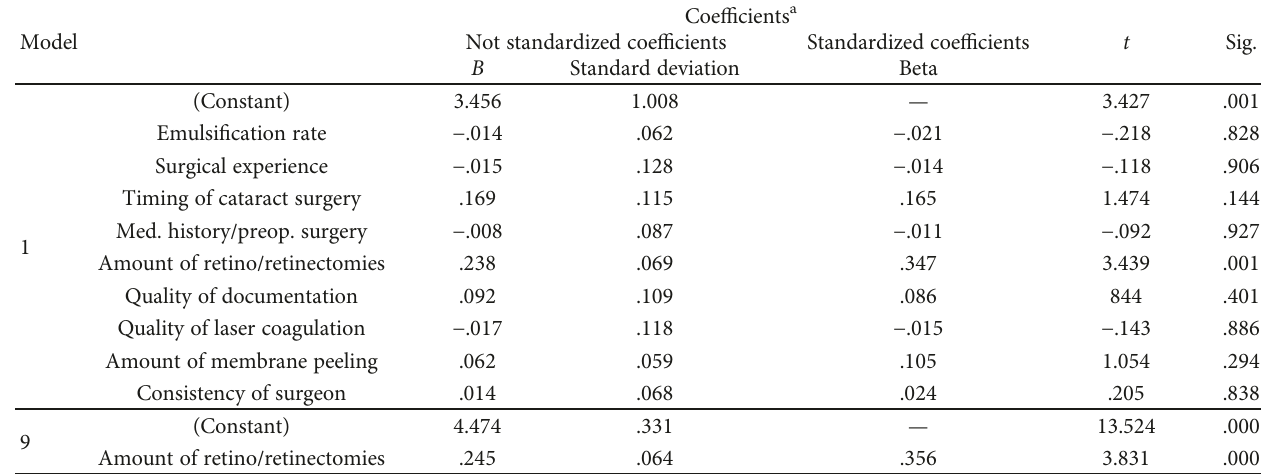
a Dependent variable: retinal redetachment